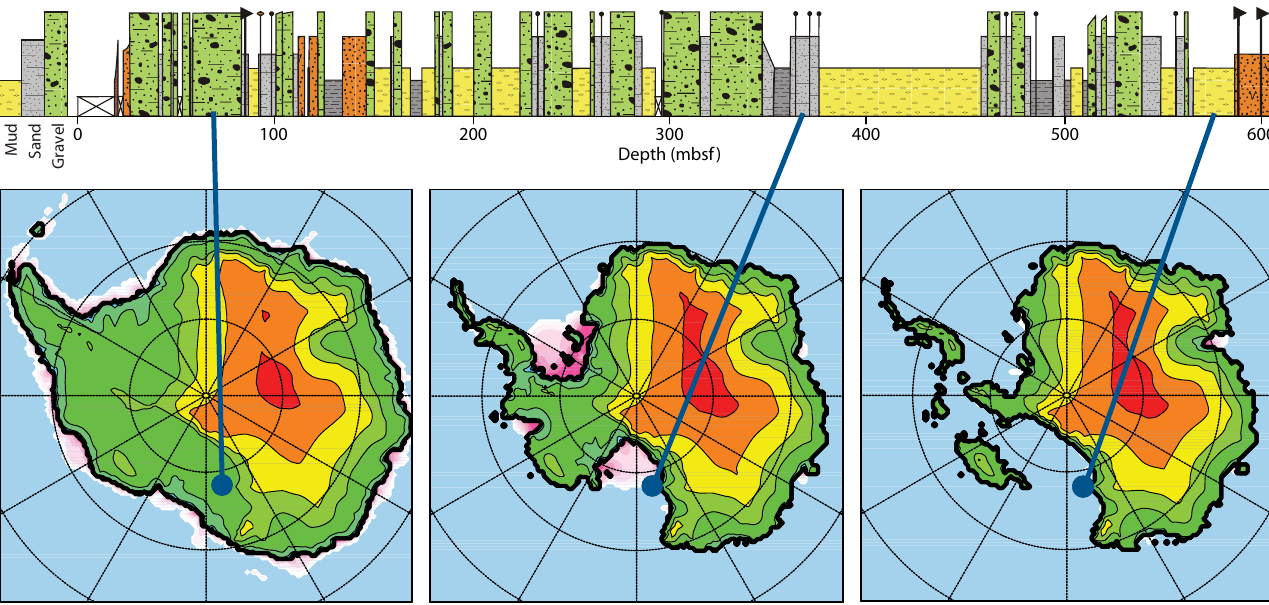
figure 2.5. an example of data-model comparison between a sediment core recovered from the antarctic margin (top and blue dots on maps; naish et al., 2009) and snapshots from a model simulation of the antarctic ice sheet spanning the last 5 million years (bottom; pollard and deconto, 2009). in the sediment core, diatomite (yellow) dominates during the older warmer pliocene interval around 3 million years ago (~400 meters core depth), indicating open water and a smaller West antarctic ice sheet (right panel). The presence of mud and sandstone (gray) at the drill site indicates a proximal ice sheet grounding line and an ice sheet configuration similar to today (middle). diamictite (green), which records the advance of a grounded ice sheet over this site during glacial maxima, has become the dominant facies over the last 900,000 years (upper 80 meters of core), including at the last glacial maximum about 20,000 years ago